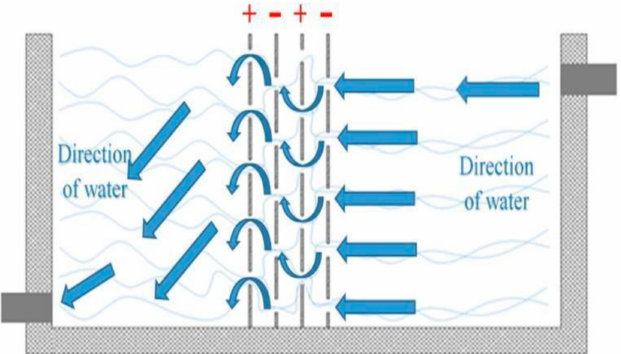
Figure 16. Electrode design and electrode arrangement to promote mixing [25].